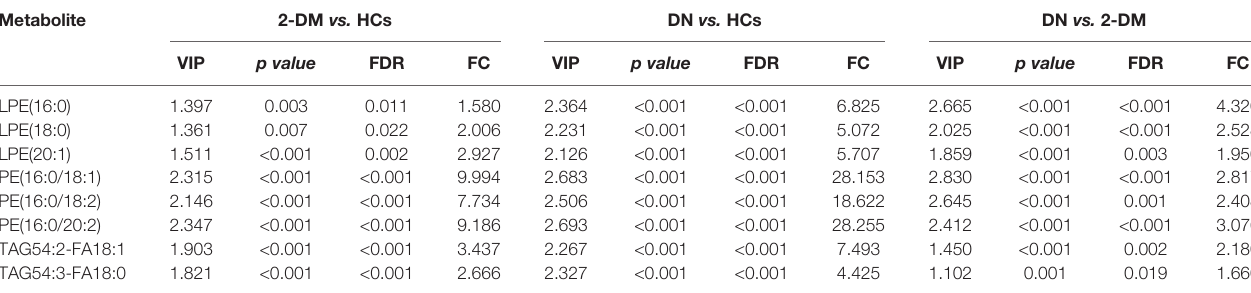
TABLE 2 | Identi fi ed differential metabolites between the 2-DM, DNE, DNA and health controls. Metabolite 2-DM vs. HCs DN vs. HCs DN vs. 2-DM